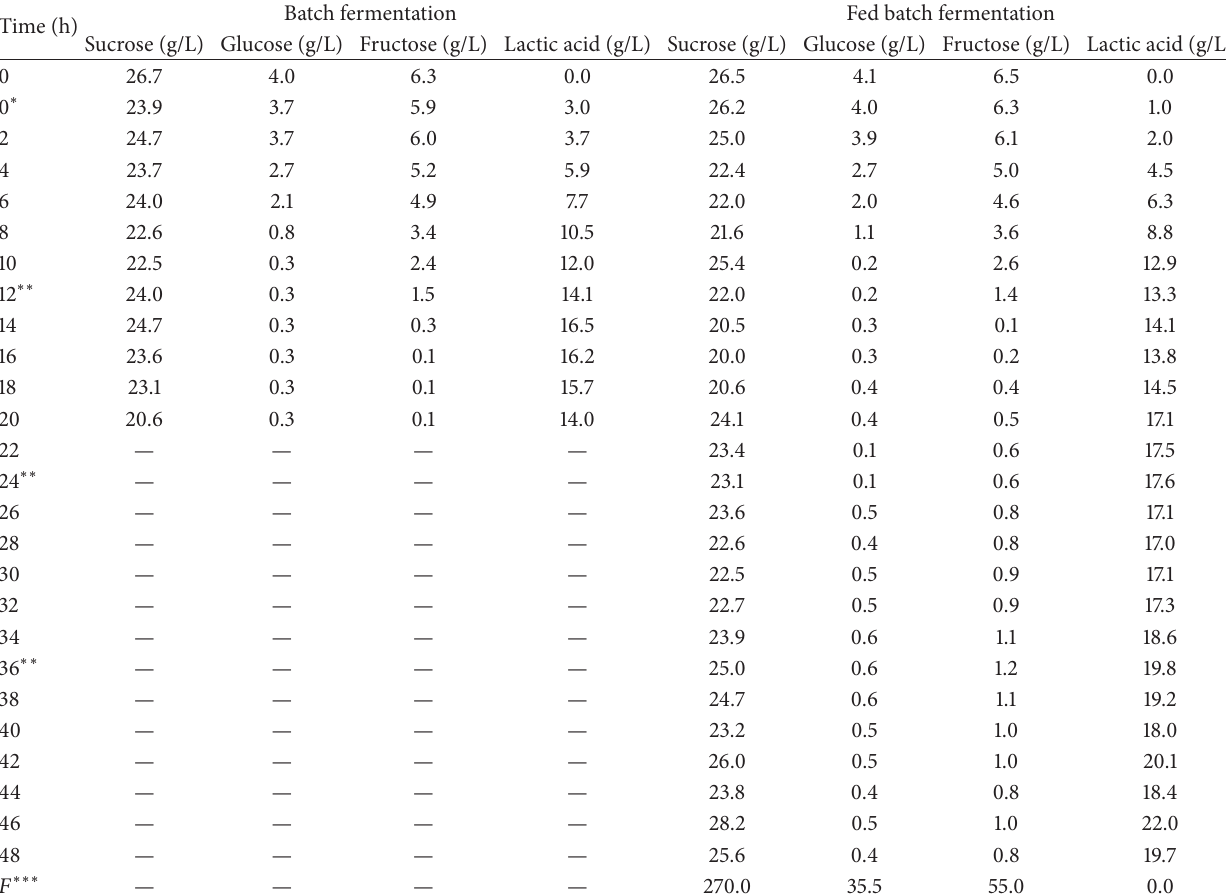
Table 1: Sugars and lactic acid values obtained at batch and fed batch L. rhamnosus ATCC 10863 fermentations. Batch fermentation Fed batch fermentation Time (h)